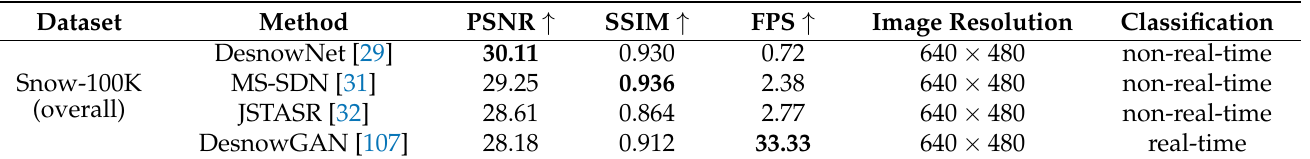
Table 8. Quantitative results of desnowing methods along with their running time. ↑ means higher is better. In bold we indicate the best result among the evaluated